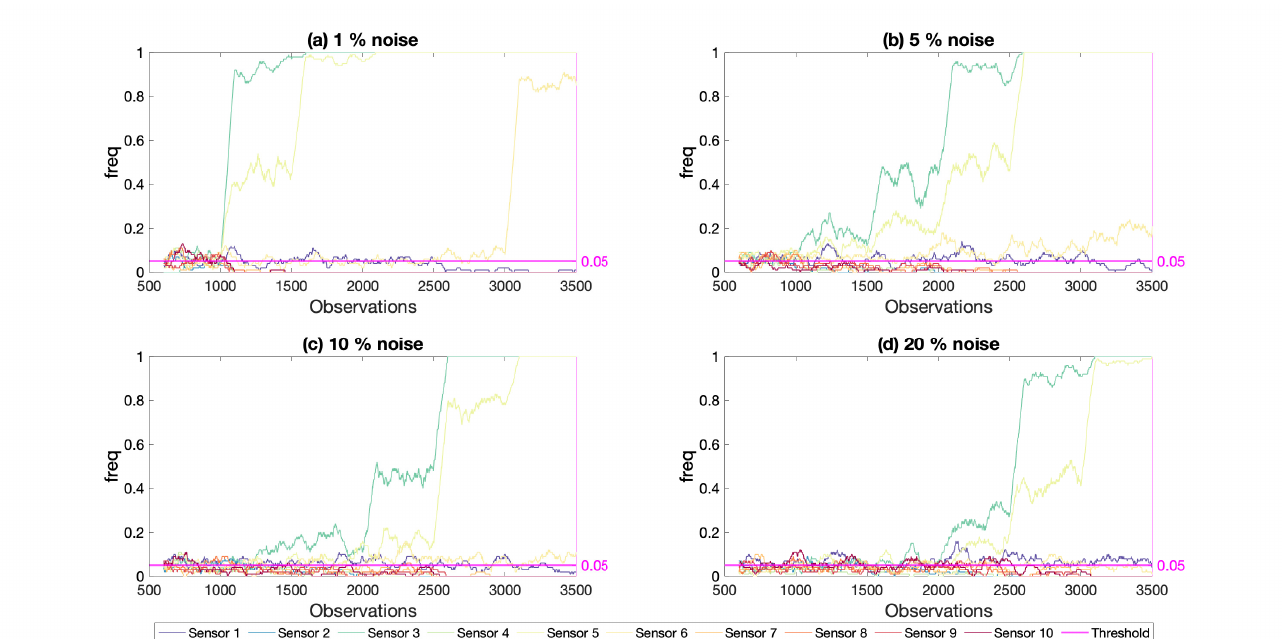
Figure 18. Frequency of exceedance using modal strain energy with two modes for different noise levels, increasing damage at mid-span (location 3) and 5%